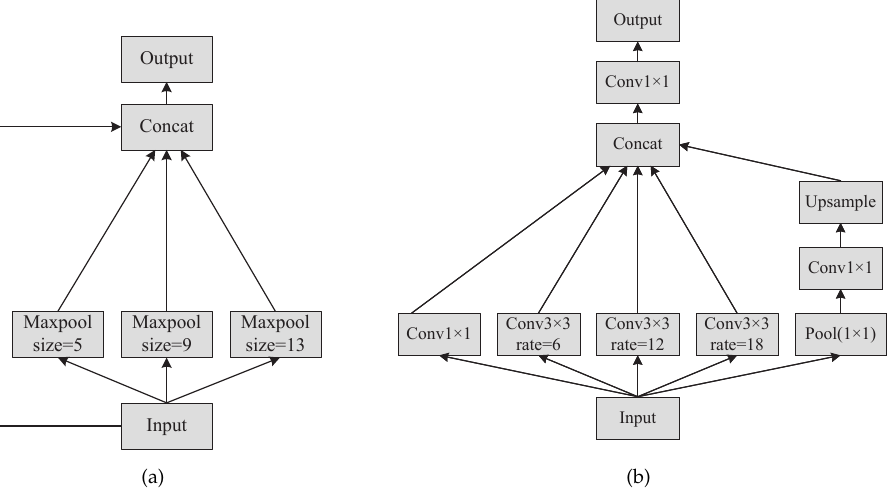
Figure 5. Network structure of two pooling ways. ( a ) Spatial Pyramid Pooling (SPP). ( b ) Atrous Spatial Pyramid Pooling